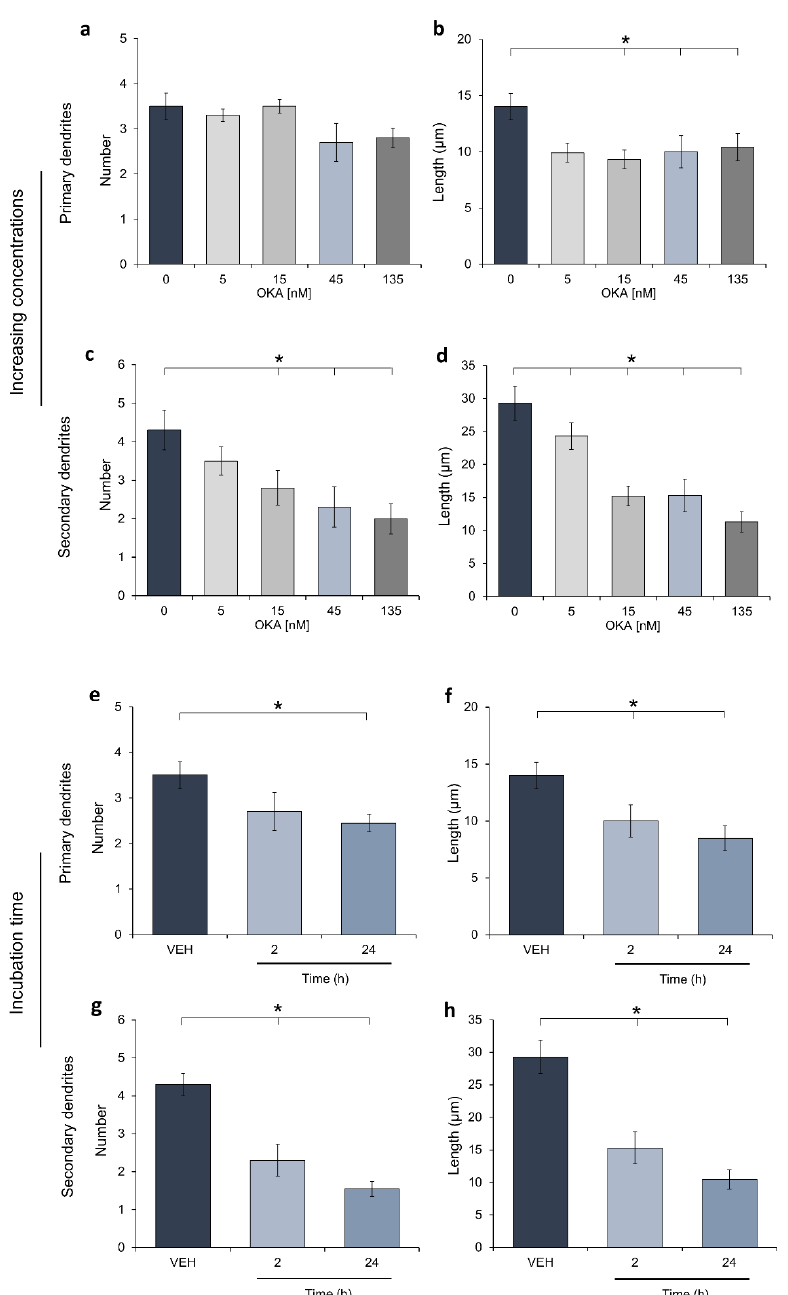
Figure 1. E ff ects of increasing okadaic acid concentrations on dendrite properties. Rat hippocampal slices (400 µ m) were cultured for one week and increasing concentrations of okadaic acid (OKA) or the vehicle (VEH; 0.00004% ethanol) were applied at the 8th day (5 slices / concentration). After a 2 h-incubation, slices were immediately fixed as described in the methods section. Then, 400 µ m slices were cut into 50 µ m cryosections to be processed for MAP2 detection by immunohistochemistry. Acquired images were processed by a modified Sholl analysis to assess dendritic formation in the hippocampal hilar neurons. Panels ( a – d ) show data corresponding to the e ff ect of increasing concentrations of OKA in the properties of primary and secondary dendrites. Panels ( e – h ) show dendrite properties measured after incubation of hippocampal slices with either the VEH (2 h) or 45 nM OKA during 2 or 24 h. Data are the mean ± SEM, determined in 4 neurons by slice (20 neurons / group). Statistical di ff erences were assessed through ANOVA on Ranks and a Student-Newman-Keuls post hoc test; * depicts p <